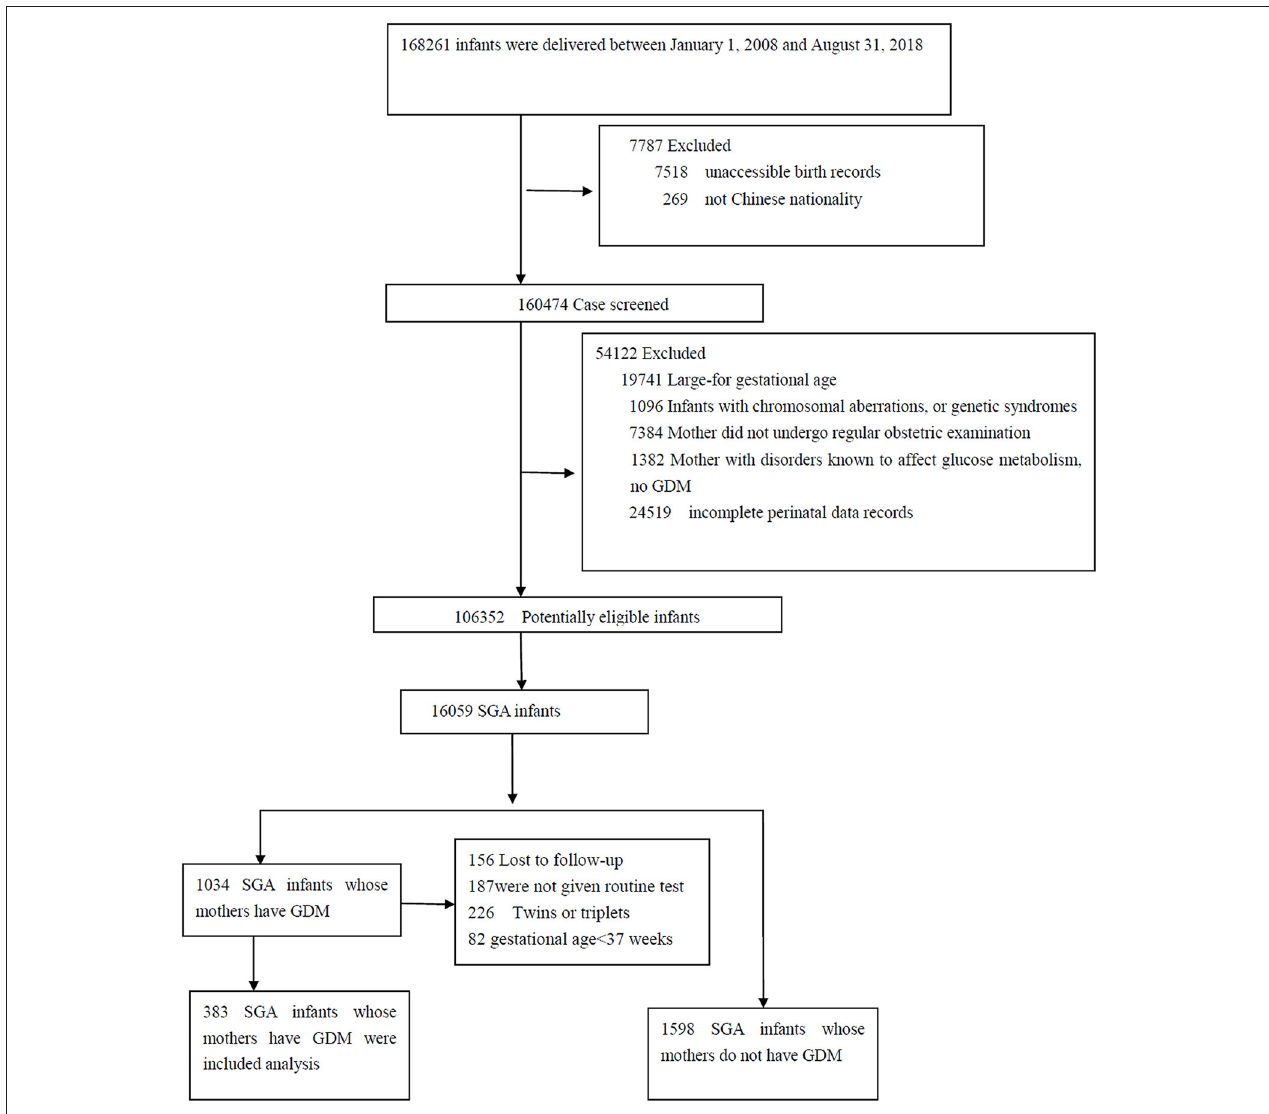
FIGURE 1 | Flow diagram of study